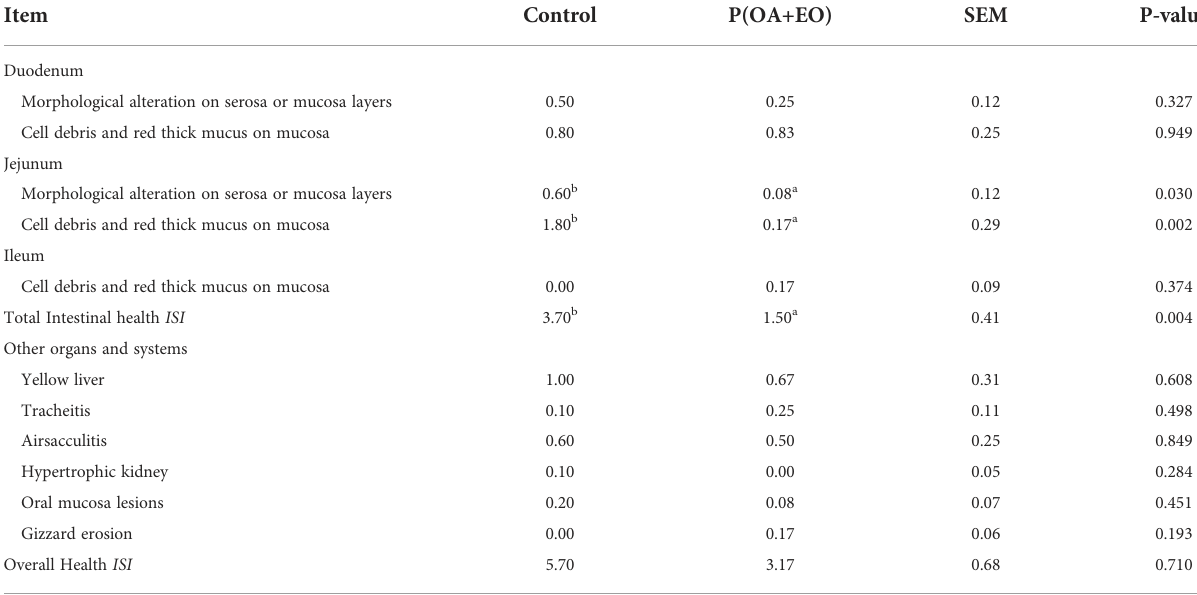
TABLE 3 Macroscopic intestinal and overall health – ISI score at 21 weeks of